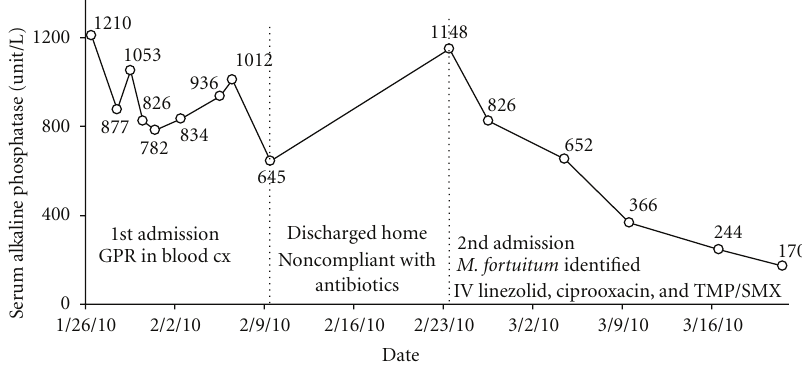
Figure 4: Serum alkaline phosphatase level trend in response to antibiotic treatment. (Normal serum level is 38–126 unit/L.)